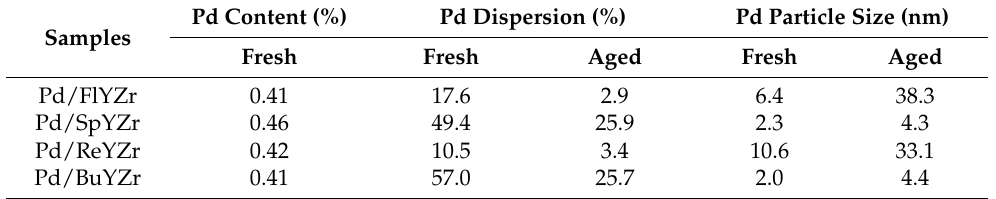
Table 2. Pd dispersion and particle size of Pd/Y-ZrO2 catalysts with different morphologies.